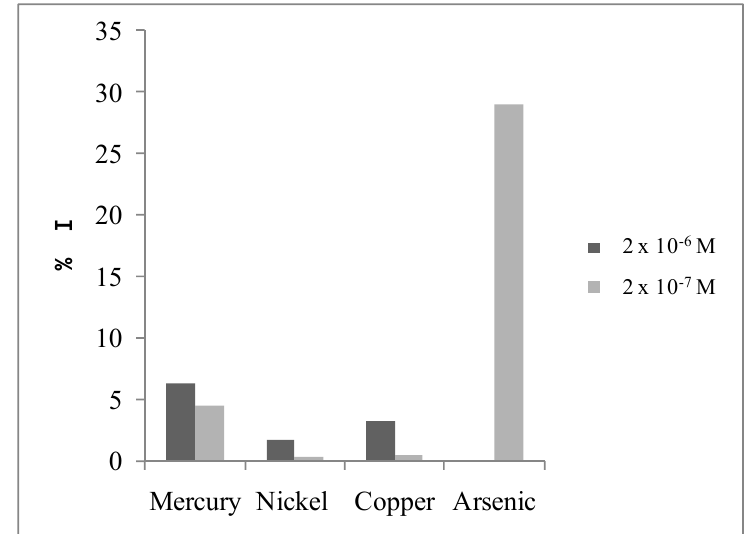
Figure 2. Percentage of inhibition % I caused by different metals. E Ag/AgCl, Britton-Robinson buffer pH = 7 and acetylthiocholine iodide concentration 3.64 × 10 − 4